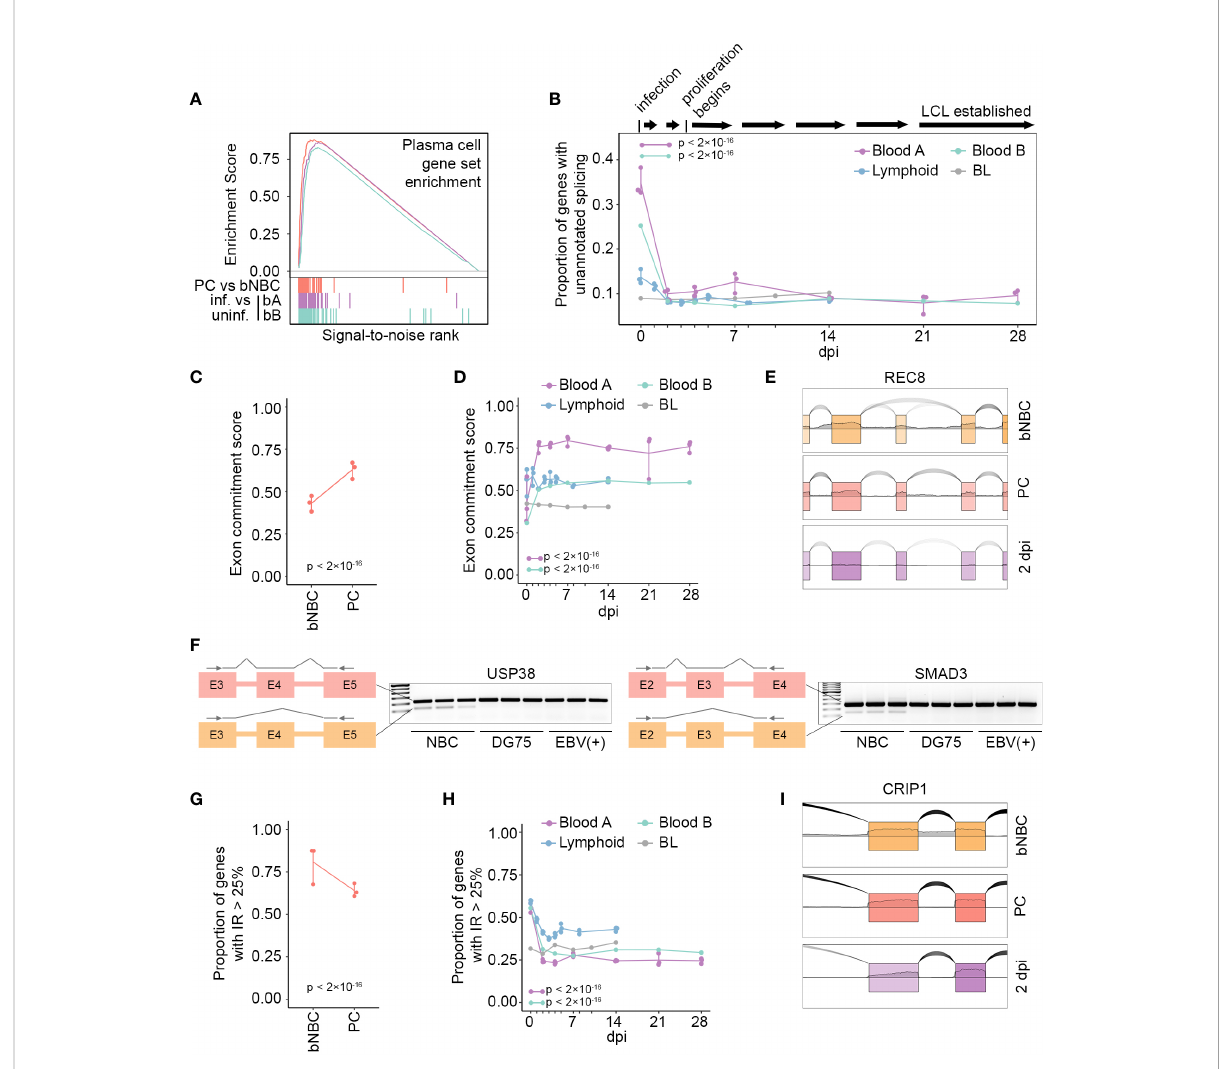
FIGURE 2 In vivo or in vitro activation of B cells restores the splicing program. (A) Enrichment scores from GSEA of gene expression level changes in PCs compared to blood NBCs (PC vs bNBC, red, maximum enrichment score = 0.880, p = 0), EBV-infected blood B cells from timecourse A at 28 dpi compared to uninfected cells (bA: purple, maximum enrichment score = 0.863, p = 0) and EBV-infected blood B cells from timecourse B at 28 dpi compared to uninfected cells (bB: green, maximum enrichment score = 0.829, p = 0). Gene set: TARTE_PLASMA_CELL_VS_B_LYMPHOCYTE_UP from MSigDB. Colored vertical lines indicate genes in the gene set. (B) Proportion of genes (TPM > 10) with unannotated splicing after EBV infection. A timeline of EBV infection events is at top. P-values calculated using a pairwise comparison of proportions test with Bonferroni correction are indicated for Blood A and Blood B, 2dpi compared to 0 dpi. (C) Exon commitment score for blood NBC (bNBC) and PC samples. Exon commitment score = proportion of exons either fully included (rMATS IncLevel > 0.99) or fully excluded (rMATS IncLevel < 0.01) in genes with TPM > 10. P-value calculated using 2-sample test for equality of proportions with continuity correction. (D) Exon commitment scores after EBV infection. P-values calculated using a pairwise comparison of proportions test with Bonferroni correction are indicated for Blood A and Blood B timecourses, 2dpi compared to 0 dpi. (E) Example of uncommitted exon in blood NBCs that is committed by increased inclusion upon differentiation to PC or EBV infection (2 dpi, Blood A), plotted with SpliceV. (F) Transcript diagrams and RT-PCR gels showing skipped exons in transcripts of USP38 (left) or SMAD3 (right) in naïve B cells from 3 donors but not in differentiated B cell lines DG75 (EBV-negative) or Akata (EBV-positive). Arrows in diagrams indicate primer positions. (G) Proportion of genes containing introns with high retention (IRFinder IRratio > 0.25) in blood NBC (bNBC) and PC samples. P-value calculated using 2-sample test for equality of proportions with continuity correction. (H) Proportion of genes containing introns with high retention levels at multiple timepoints after EBV infection. P-values calculated using a pairwise comparison of proportions test with Bonferroni correction are indicated for Blood A and Blood B, 2dpi compared to 0 dpi. (I) Example of intron retention in blood NBCs reduced upon differentiation to PC or EBV infection (2 dpi, Blood A), plotted with SpliceV. Blood A = blood infection timecourse A, 3 replicates, Blood B = blood infection timecourse B, 1 replicate, Lymphoid = adenoid infection timecourse, 3 replicates. BL = Akata-EBV-N Burkitt lymphoma cell infection timecourse, 1